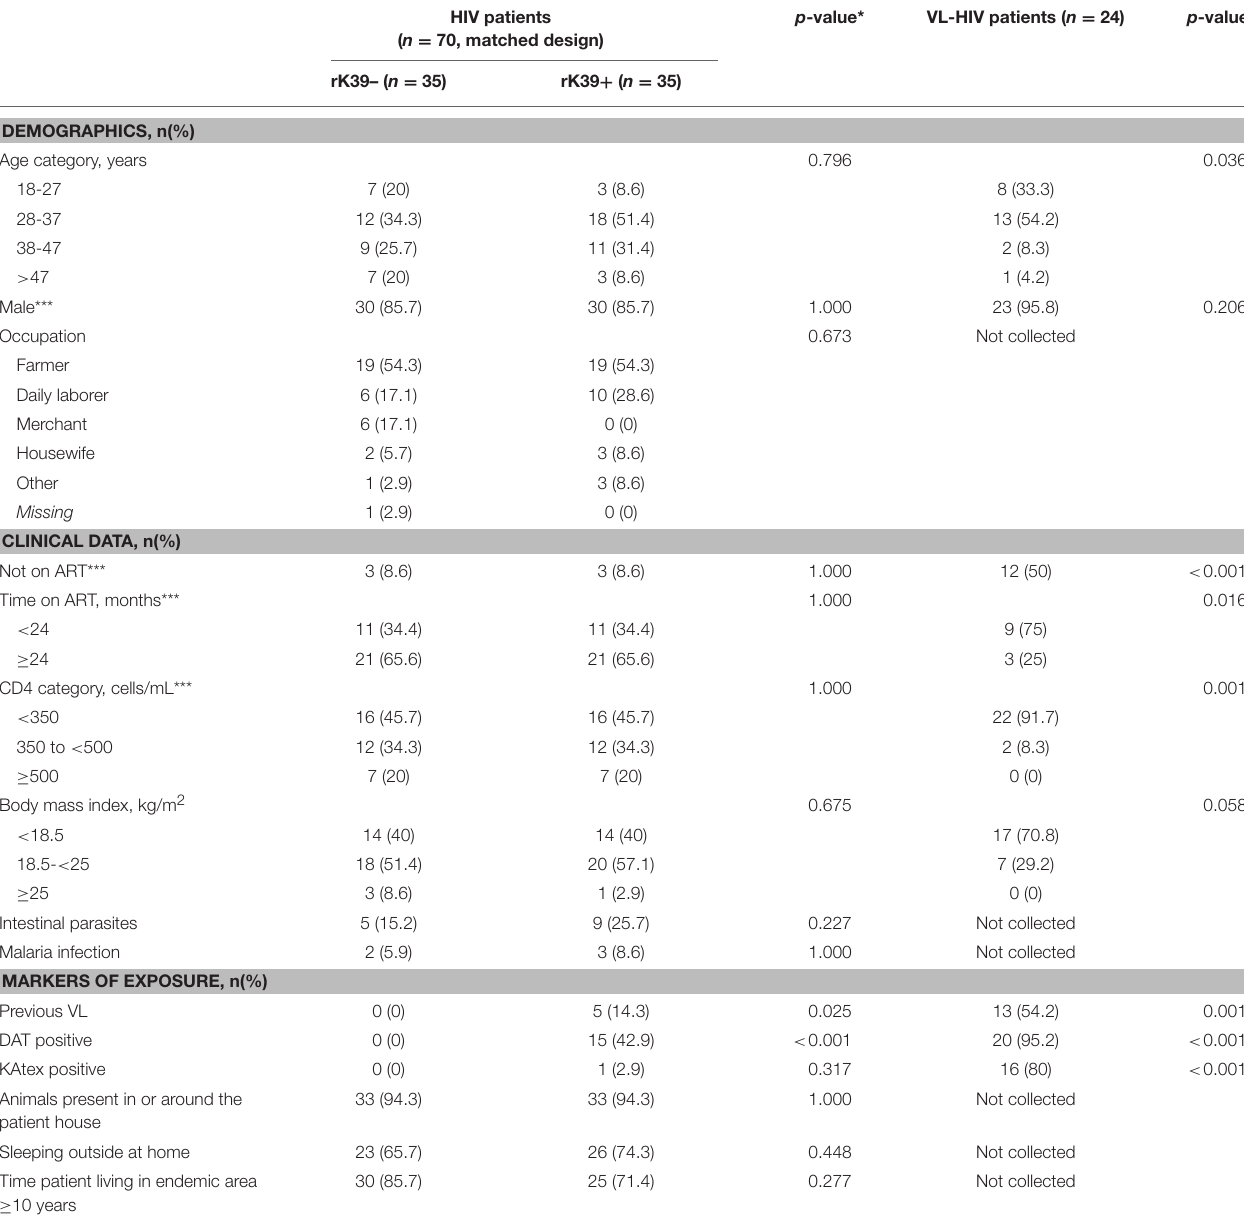
TABLE 1 | Patient characteristics.